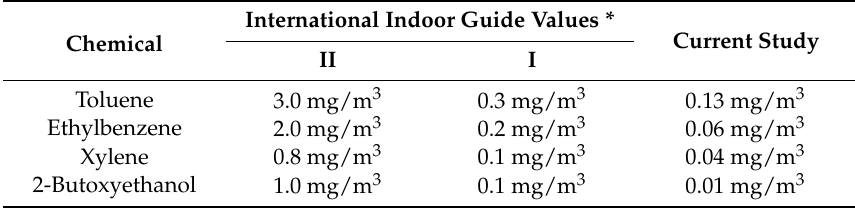
Table 8. Comparison between exposure levels current study and international indoor guide